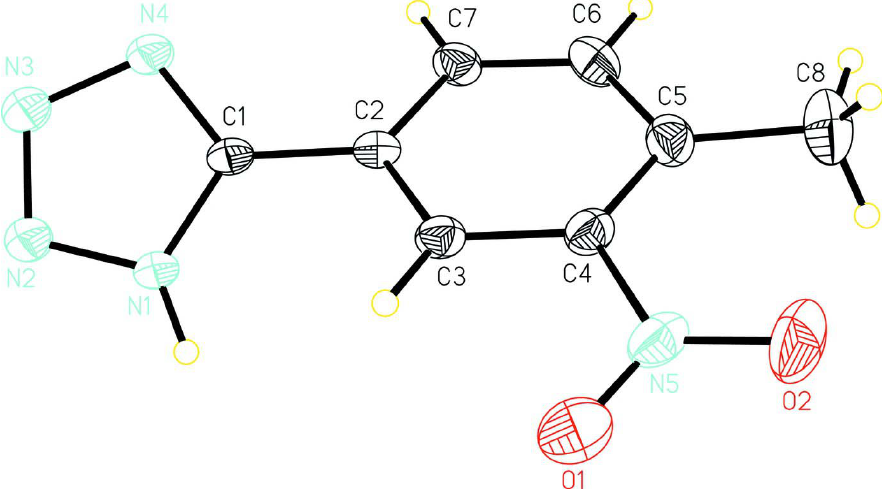
A view of the title compound with the atomic numbering scheme. Displacement ellipsoids were drawn at the 30% probability level. H atoms are represented as small spheres of arbitrary